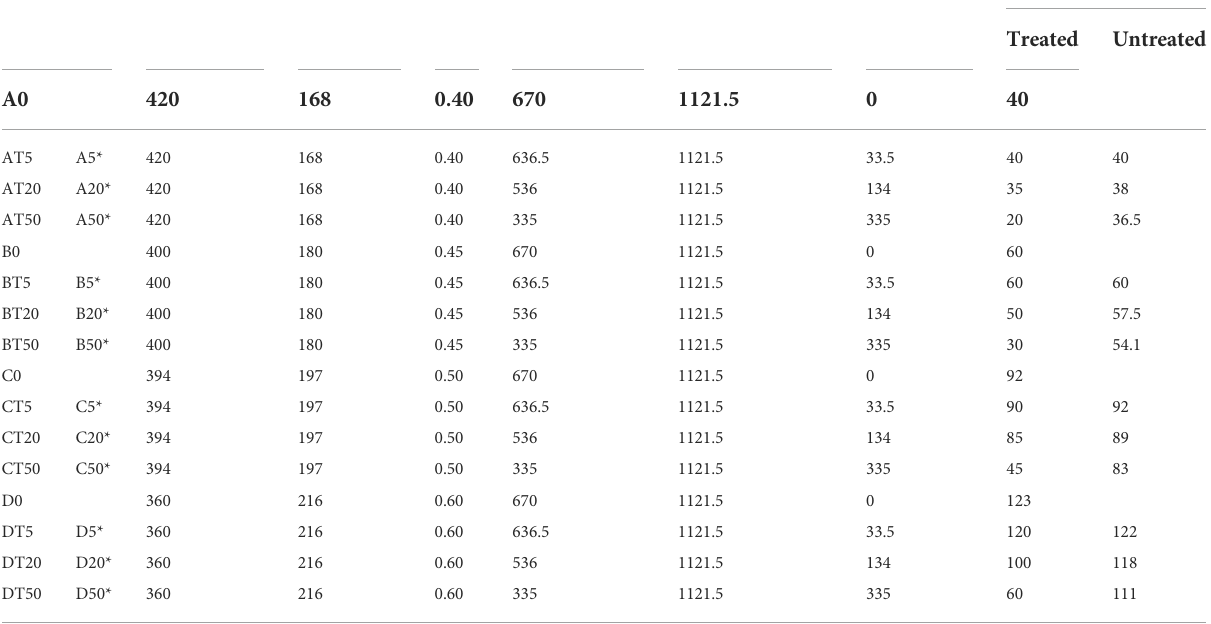
TABLE 1 Mix proportional and slump-test results.